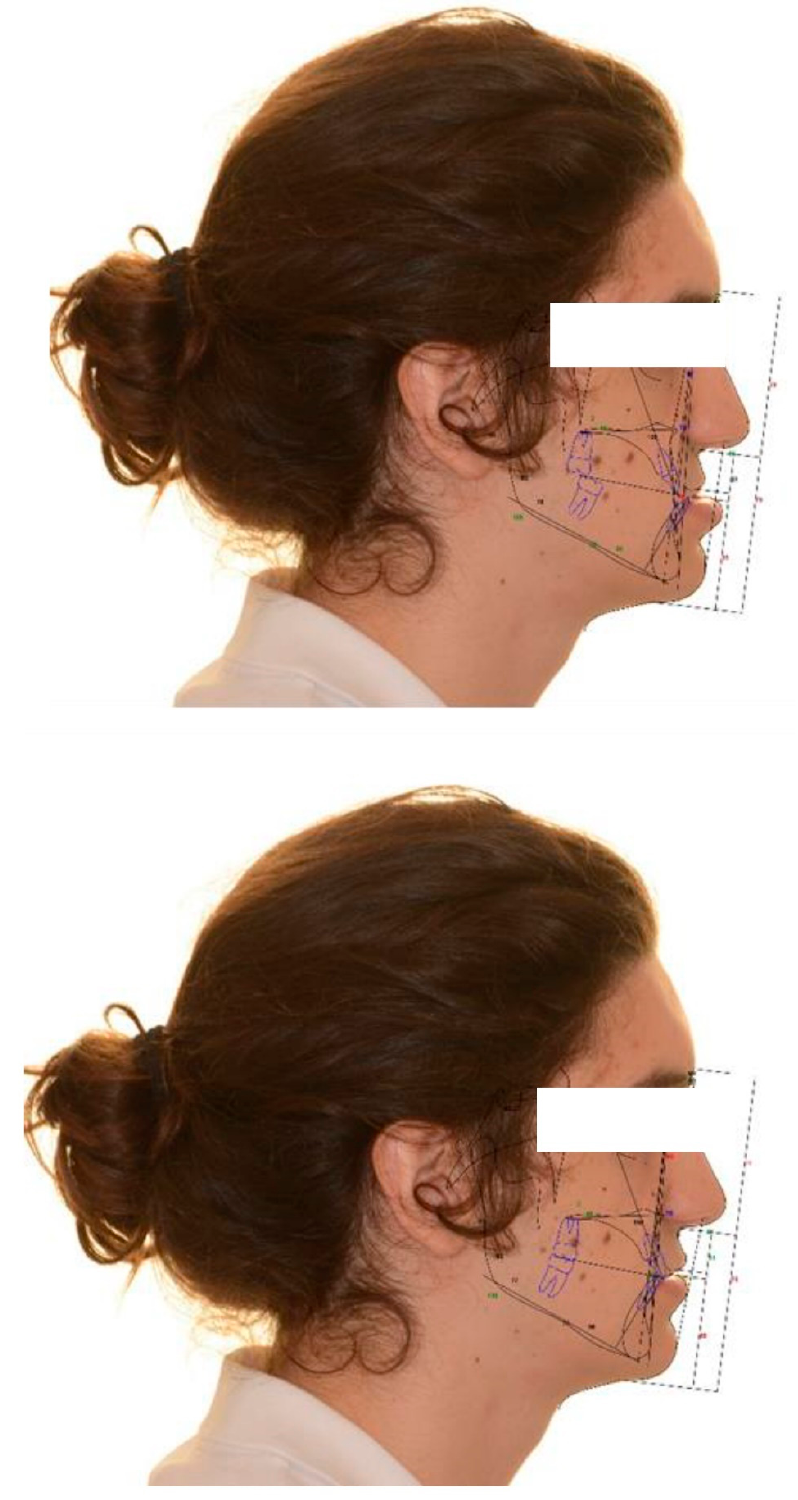
Figure 2. Pre-intervention cephalometry and VTO of a CLP patient. VTO: Visual Treatment Objec- tives; CLP: cleft lip and palate. CLP: cleft lip and